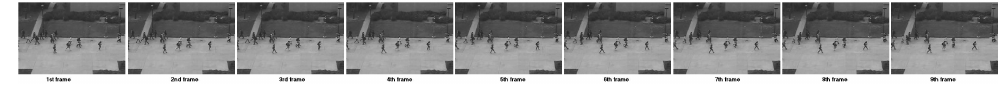
Figure 8. Sample camera view frames of UCSD-Ped2